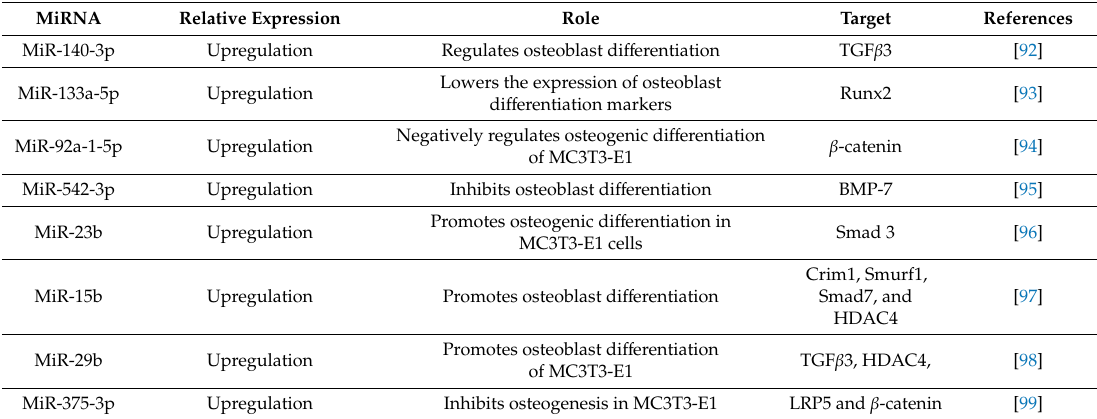
Table 5. MiRNAs involved in osteoblast regulation.